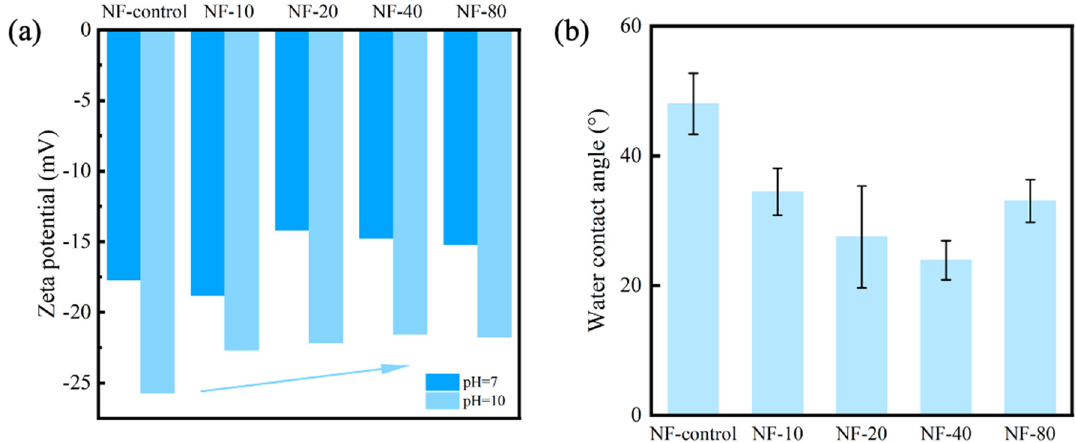
Figure 7. ( a ) Zeta potential of NF-control, NF-10, NF-20, NF-40, and NF-80; ( b ) Water contact of NF-control, NF-10, NF-20, NF-40, and NF-80.